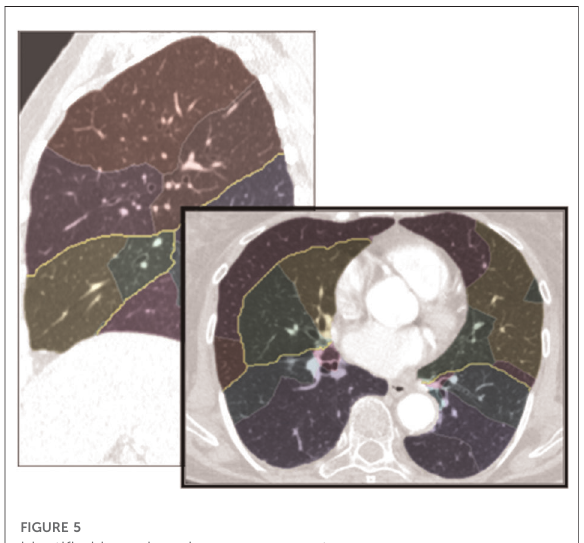
FIGURE 5 Identi fi ed bronchopulmonary segments.